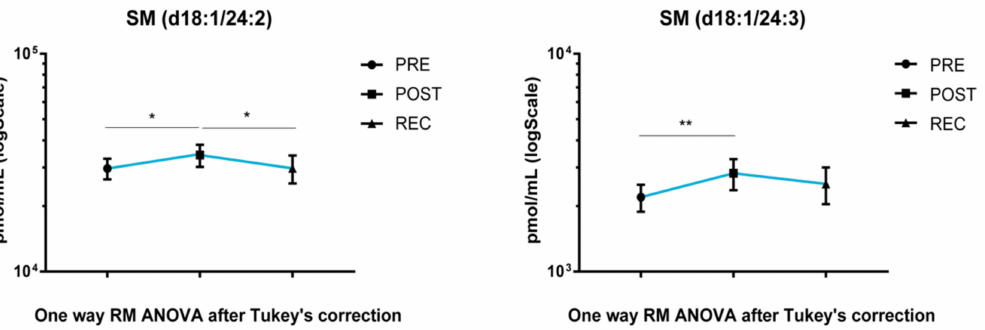
Figure 4. LC-MS analysis results for sphingomyelins in cocktail-treated subjects’ serum. Results are expressed as pmol/mL in Log scale (PRE n. 10, POST n. 10, REC n. 10). p -values are indicated as: * p -value < 0.05 and ** p -value < 0.01.